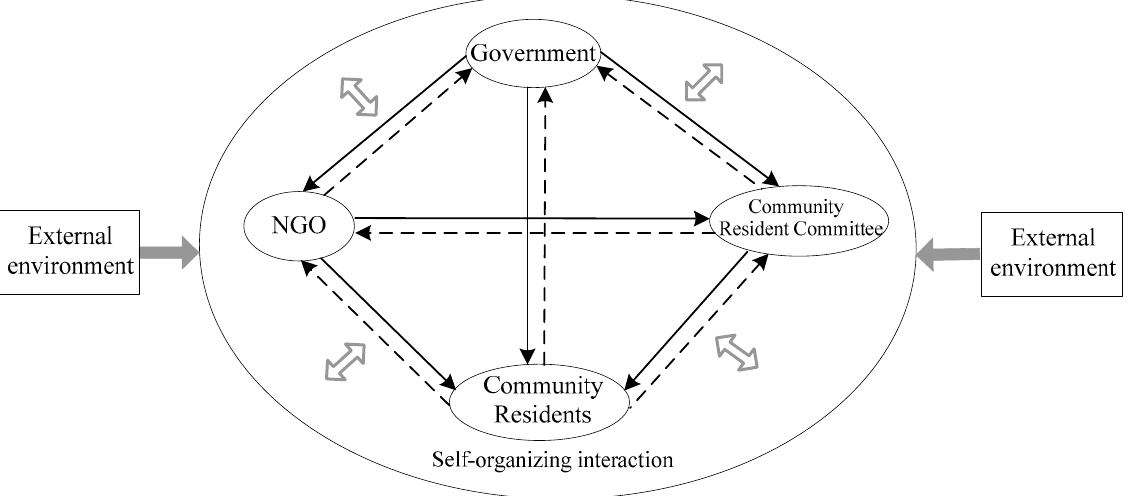
Figure 2. Schematic diagram of the collaborative governance system for community public health emergencies.